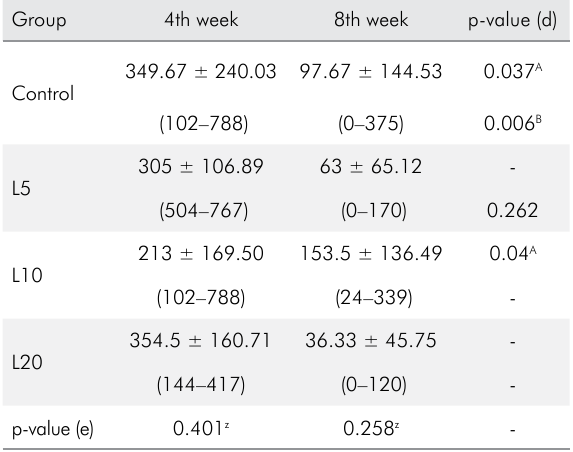
Table 2. Analysis of osteoblast number among groups and dependent on time. Data presented as mean ± standard deviation (minimum–maximum).